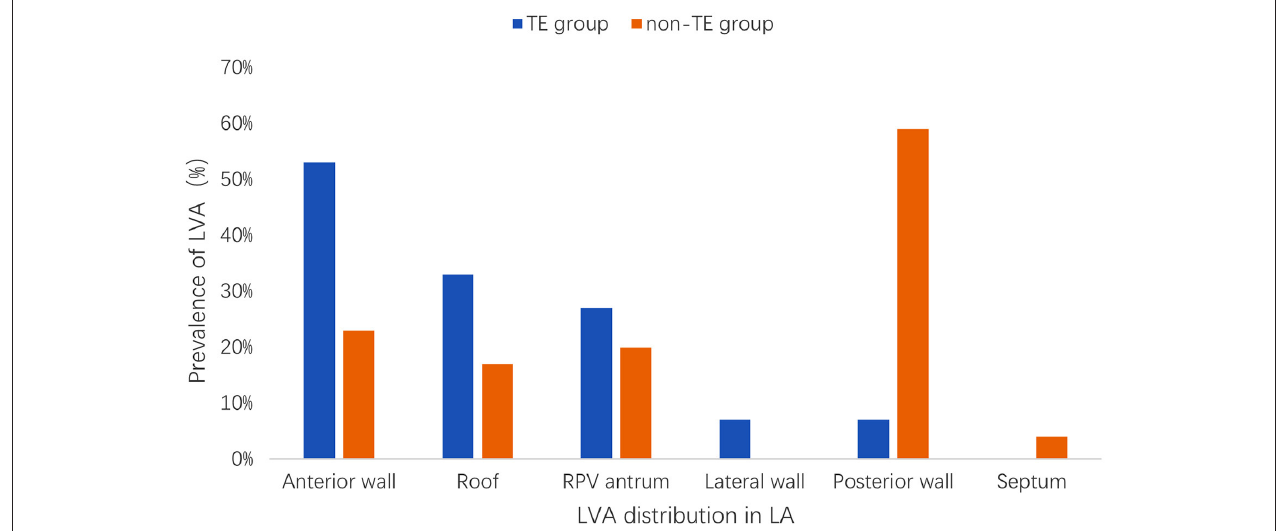
FIGURE 3 | Distribution and prevalence of LVA in LA. LVA, low voltage area; LA, left atrium; TE, thromboembolism; RPV, right pulmonary vein.